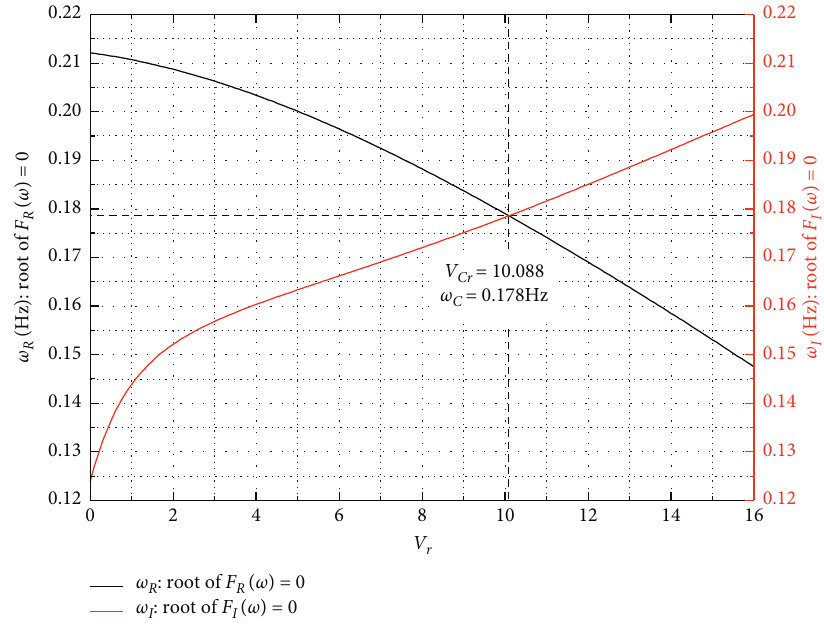
Figure 4: The intersection of the real part root and imaginary part